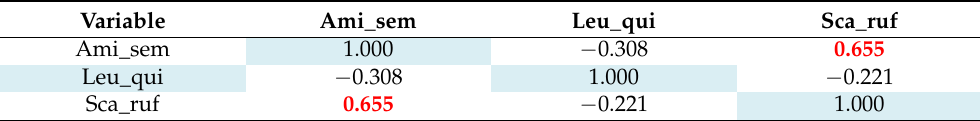
Table 3. Correlation of seasonal dynamics of the number of species L. quinquemaculata, A. semivirgo, S. rufifrons from May to October in five forest biotopes (Spearman’s rank order correlations). Signifi- cant correlation coefficients are highlighted in red, with values greater than 0.6 in bold.